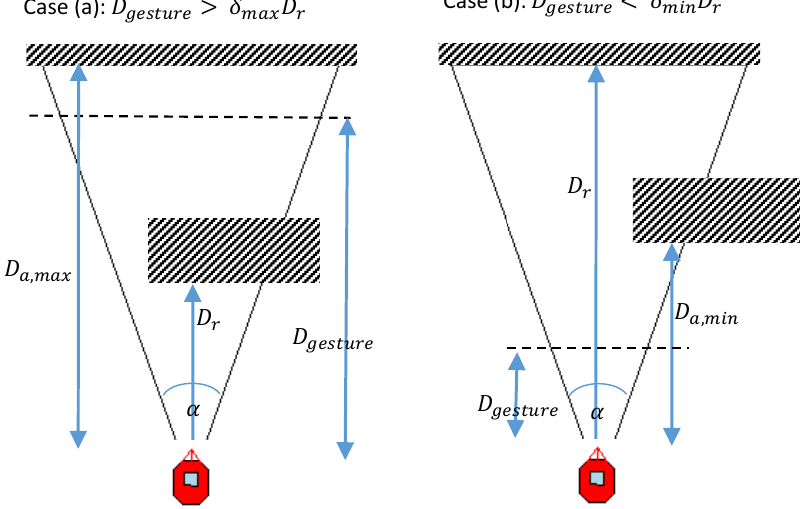
Figure 5. The ways to estimate the alternative perceptive distances are illustrated for the possible two scenarios. The shaded areas represent the obstacles/objects in the environment that are in near vicinity of the considered field view. The field angle is denoted as α . The dashed-line represents the perpendicular drawn to the intended moving path from the evaluated gesture pointing position in each scenario. D gesture is calculated based on the point referred by the gesture as explained in Section 3.3.2. D r , D a , min and D a , max are computed based on the data of navigation map. This illustrates the parameter estimation considering the indented moving direction as forward. The same is applied for other directions